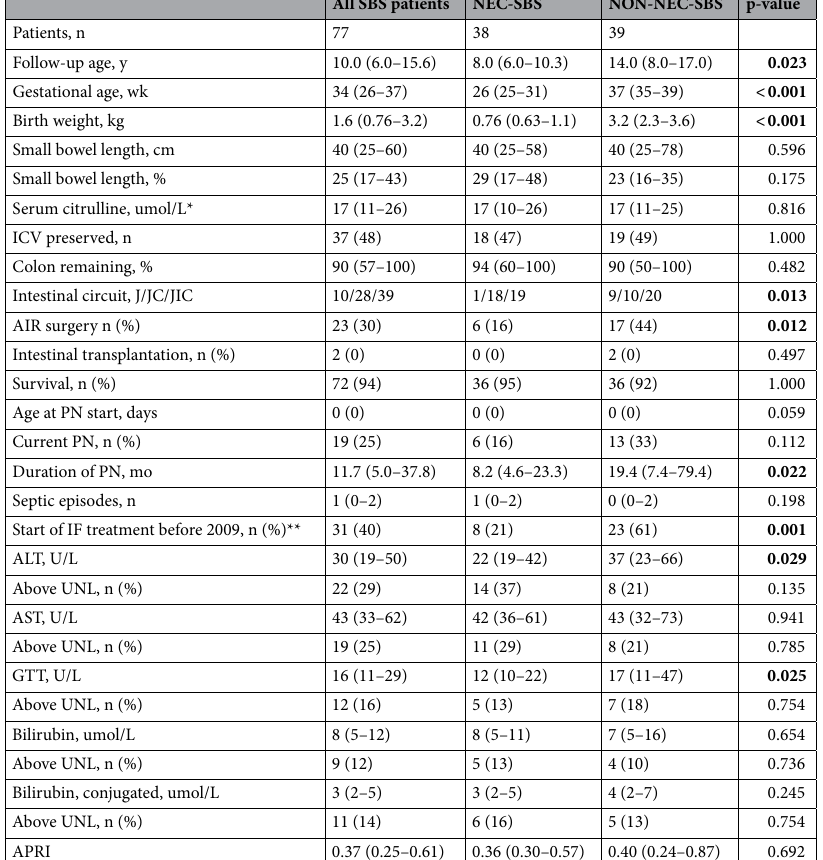
(interquartile range) or frequencies. P-values are Mann Whitney U-test or Fisher’s exact test. AIR Autologous intestinal reconstruction, ALT alanine aminotransferase, APRI AST-to-platelet ration index, AST aspartate aminotransferase, GTT gamma-glutamyl transferase, ICV Ileocecal valve, J end-jejunostomy, JC jejunocolic anastomosis, JIC jejunoileocolic anastomosis, NEC necrotizing enterocolitis, PN parenteral nutrition, SBS